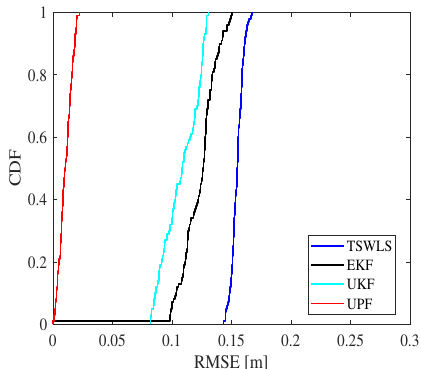
Figure 4. The RMSE of different algorithms in NLOS scenario ( σ θ